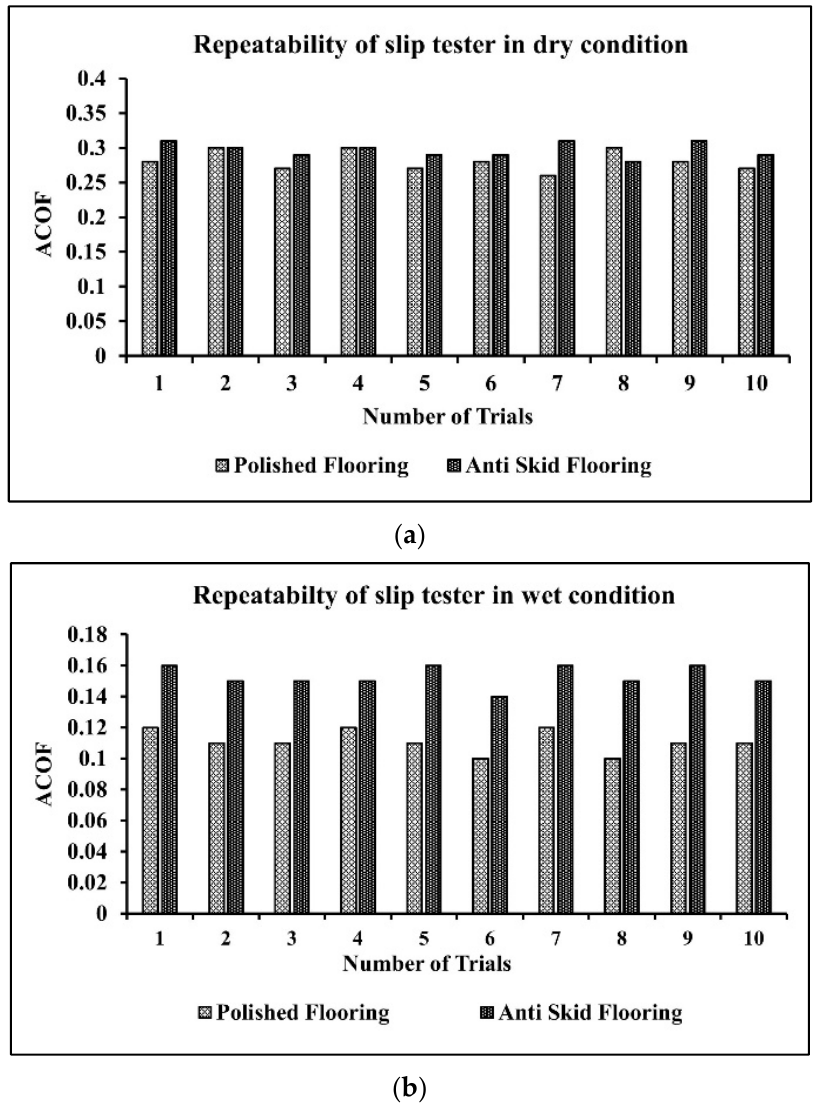
Figure 7. Repeatability of slip tester in: ( a ) dry condition, and ( b ) wet condition.